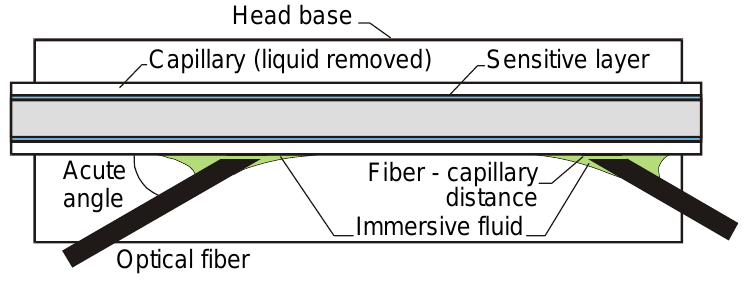
Figure 8. Capillary evanescent field head with optical fibers positioned at an acute angle